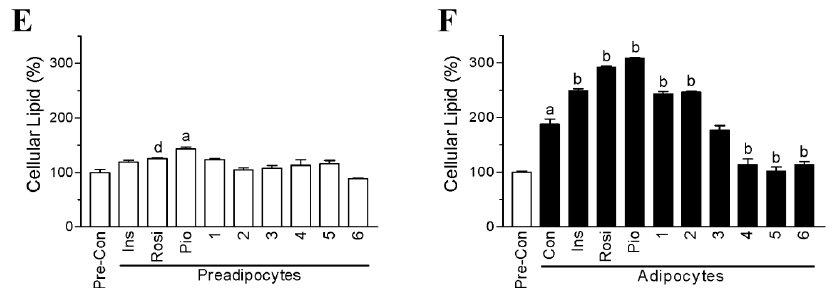
Figure 2. Effects of chalcone derivatives on glucose consumption and lipid accumulation in preadipocytes and adipocytes. 3T3-L1 preadipocytes or adipocytes were incubated with vehicle (0.1% dimethyl sulfoxide; Control), insulin (0.32 µM; Ins), rosiglitazone (30 µg/mL; Rosi), pioglitazone (30 µg/mL; Pio) or 30 µg/mL of chalcone derivatives (compounds 1 – 6 ). ( A ) Percentage of medium glucose consumed by the preadipocytes; ( B ) percentage of medium glucose consumed by the adipocytes; ( C ) cellular lipid accumulation in the preadipocytes; ( D ) cellular lipid accumulation in the adipocytes. Red color shows the cellular lipid droplets stained with Oil-Red O; ( E , F ) cellular lipid amount was quantified by dissolving the Oil Red O in isopropanol. Data are mean ± SD from three or four independent experiments. a : p < 0.001 compared to Pre-Con; b : p < 0.001 compared to Con; c : p < 0.05 compared to Con; d : p < 0.05 compared to Pre-Con. Pre-Con: control for preadipocytes; Con: control for adipocytes. The original magnification of the cell images in panel C and D is 100× under the light microscope.